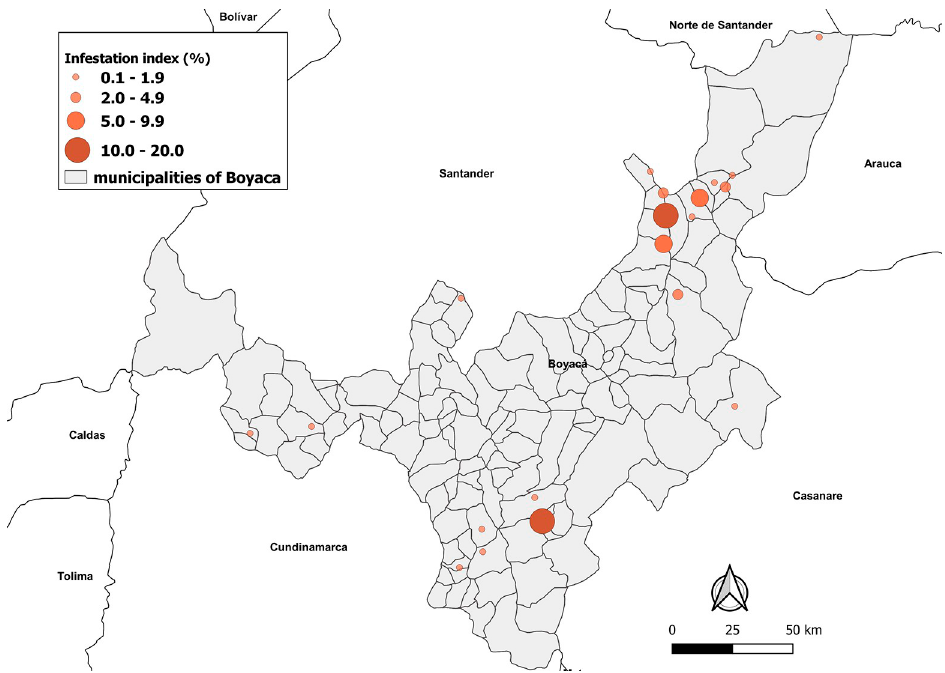
Fig 2. Geographical distribution of Triatomine Infestation indices in Boyaca department of Colombia, from March 2017 to November 2018. The map was built using the free and open source QGIS software version 3.4 (https:// www.qgis.org/en/site/forusers/download.html) and shapefiles were obtained from the free and open source DIVA-GIS site (https://www.diva-gis.org/gdata).